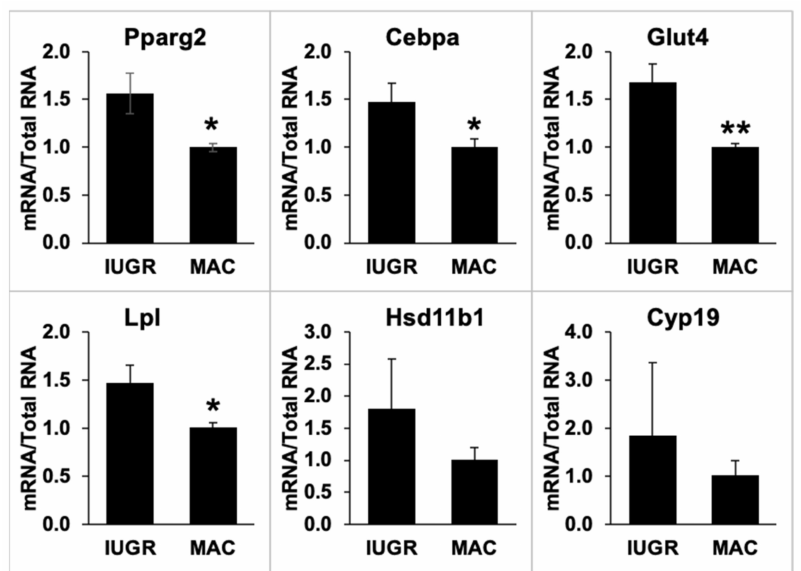
Figure 8. qPCR quantification of gene expression in gonadal fat of non-fasted IUGR and macrosomic male mice ( n = 4–5 per group.) Values for IUGR animals are expressed relative to values for the macrosomic animals. Values are mean ± SEM. * p < 0.05, ** p < 0.01 compared to